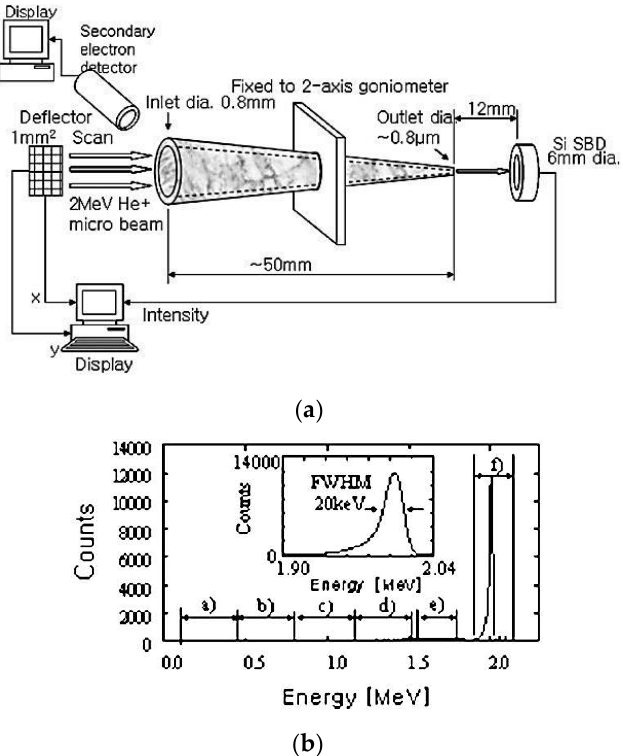
Figure 5. ( a ) Schematics of the experimental arrangement (reprinted with permission from [3]. Copyright 2003, American Vacuum Society) and ( b ) energy spectrum of the transmitted ions measured by surface barrier detector (SBD) (reprinted with permission from [3]. Copyright 2003, American Vacuum Society).